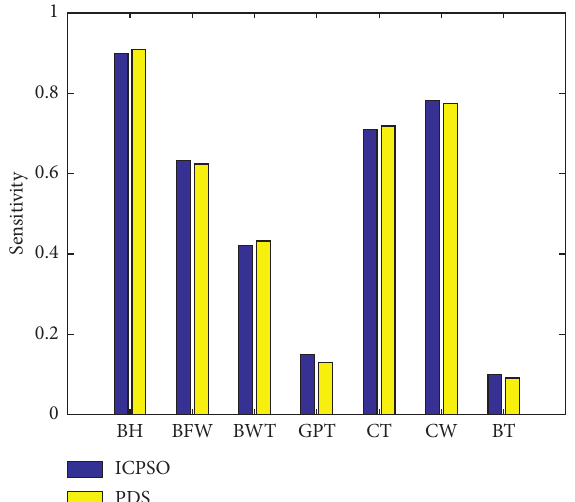
Figure 17: Sensitivity coefficient for 9% variation